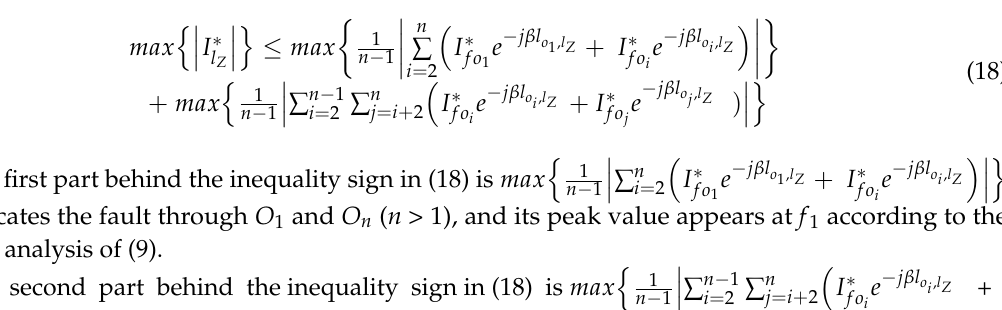
Figure 4. Fault location with multiple observers: ( a ) the maximal branch node; ( b ) the other branch node. An inequality can be derived from formula